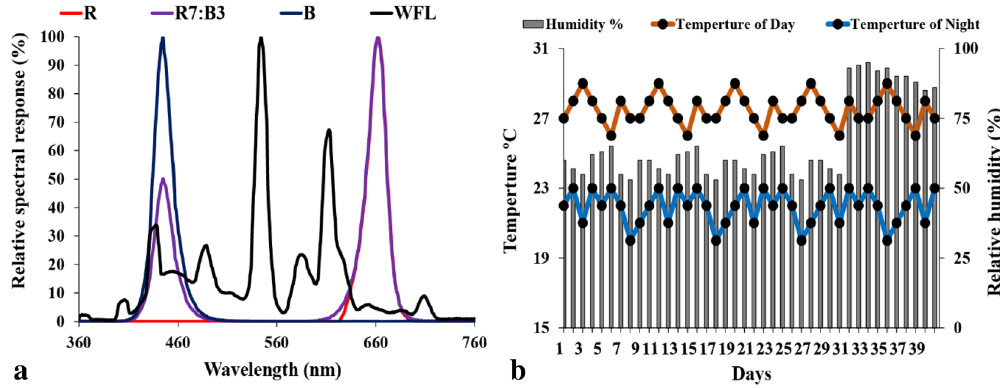
Figure 8. Spectrum distribution of the treatments LED light in the experiment ( a ) and Environmental conditions ( b ). Where R = Red light 100%, R7:B3 = Red70% + Blue30%, B = Blue light 100%, WFL = White Fluorescent Lamps100%.